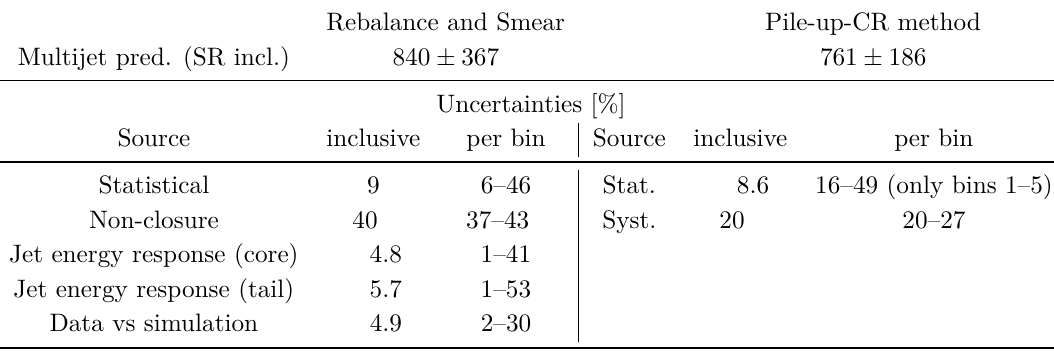
Table 4. Predicted multijet background, before the likelihood fit, entering the signal region bins with N jet = 2 with associated uncertainties from the Rebalance and Smear method and the pile-up-CR method. The quoted uncertainty in the inclusive prediction is estimated by summing uncertainties from all sources in quadrature over the SR bins. The individual sources of uncertainty are given for the inclusive SR but also as a range for the individual SR bins. The range for the statistical uncertainties of the pile-up-CR method are only shown for bins 1 to 5; for bin 6 to 10 no bin-by-bin uncertainties are evaluated since those are merged, and for bins 14 to 16 the statistical uncertainties are